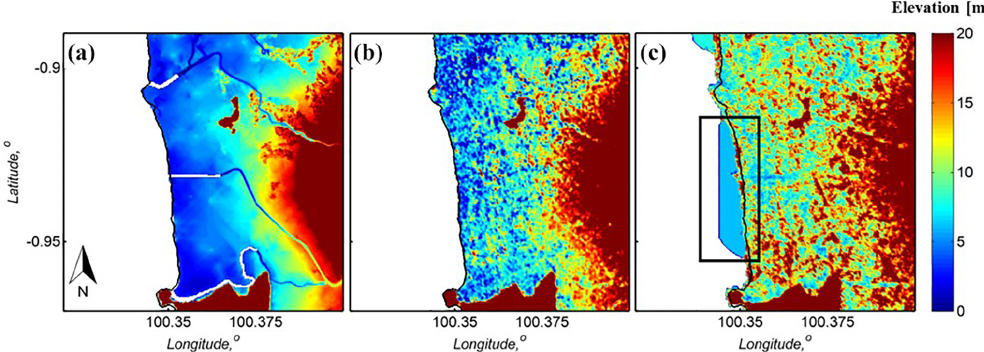
Figure 4. Digital elevation model for Padang: (a) DEM5, (b) SRTM1, and (c) GDEM2.